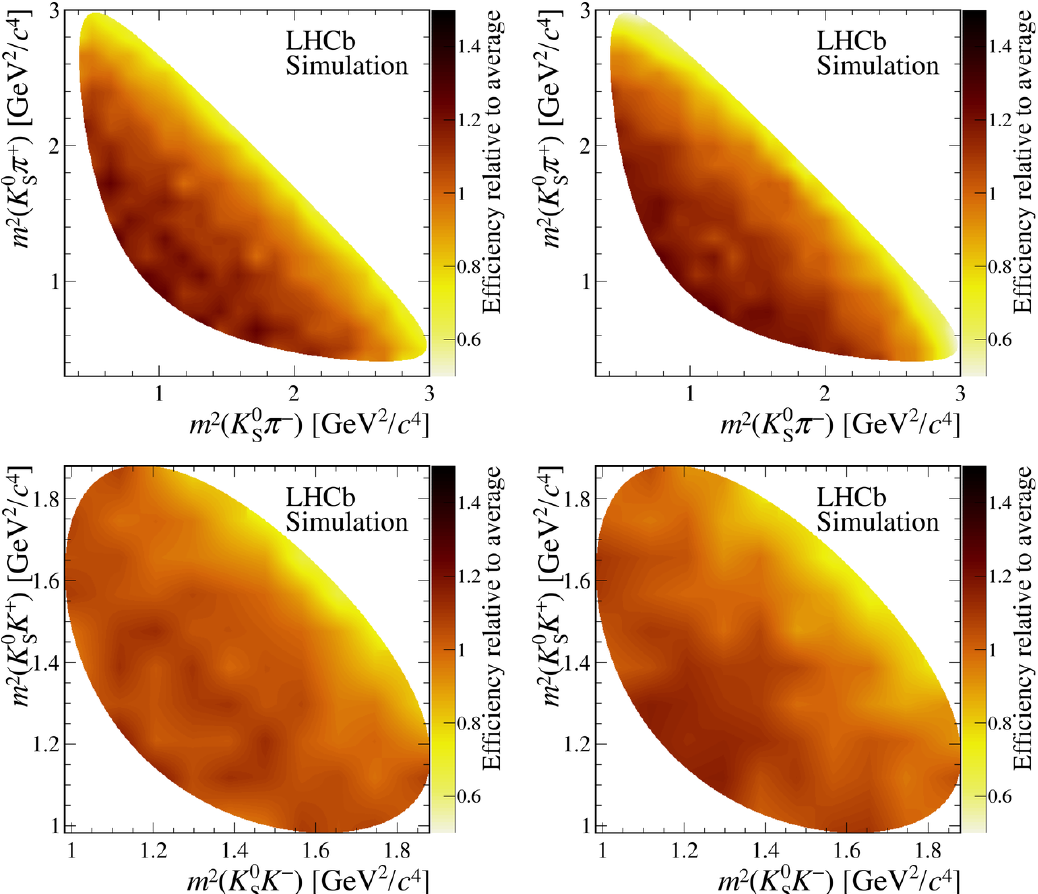
( ) Figure 6 . Example e(cid:14)ciency pro(cid:12)les of (left) B (cid:6) ! D(cid:25) (cid:6) and (right) B ! D (cid:3)(cid:6) (cid:22) (cid:7) ( ) (cid:23) (cid:22) X decays in the simulation. The top (bottom) plots are for D ! K 0 (cid:25) + (cid:25) (cid:0) ( D ! K 0 K + K (cid:0) ) decays. These S S plots refer to downstream K 0 candidates under 2016 data taking conditions. The normalisation is S chosen so that the average over the Dalitz plot is